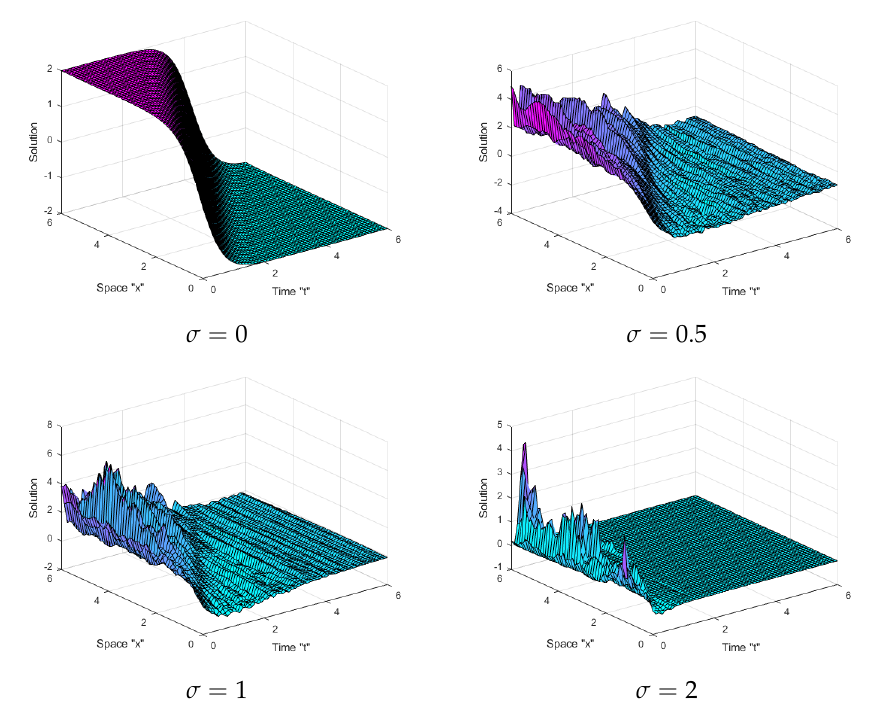
Figure 5. The 3D-profiles of solution Φ ( x , t ) in Equation (18) for various values of σ